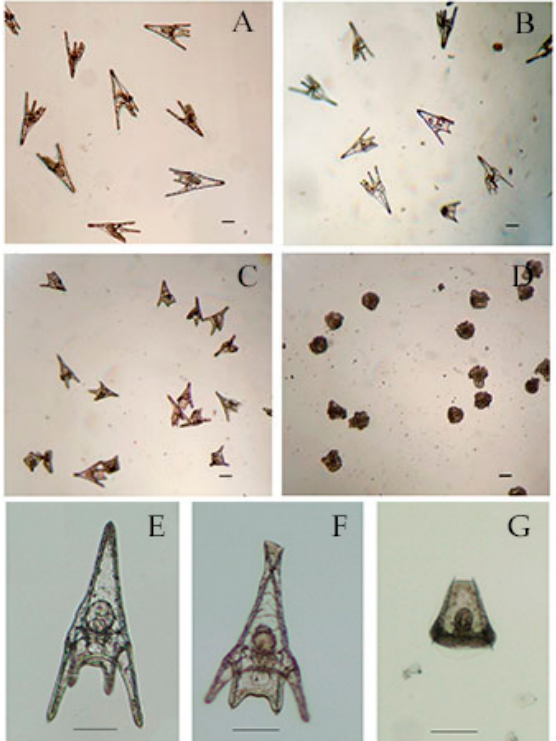
Figure 4. Micrographs of P. lividus embryos after 48 h of treatment with cyanobacteria extracts. ( A ) Control sample. ( B ) Sea urchin embryos treated with ethyl acetate extracts from Cyanobium sp. ITAC108. ( C ) Sea urchin embryos treated with hexane extracts from Synechococcus sp. ITAC107. ( D ) Sea urchin embryos treated with ethyl acetate extracts from Synechococcus sp. ITAC107. ( E ) Untreated P. lividus embryo. ( F ) Embryo treated with ethyl acetate extracts from Synechococcus sp. ITAC107. ( G ) Embryo treated with ethyl acetate extracts from Synechococcus sp. ITAC107. Bar represents 100 µm.